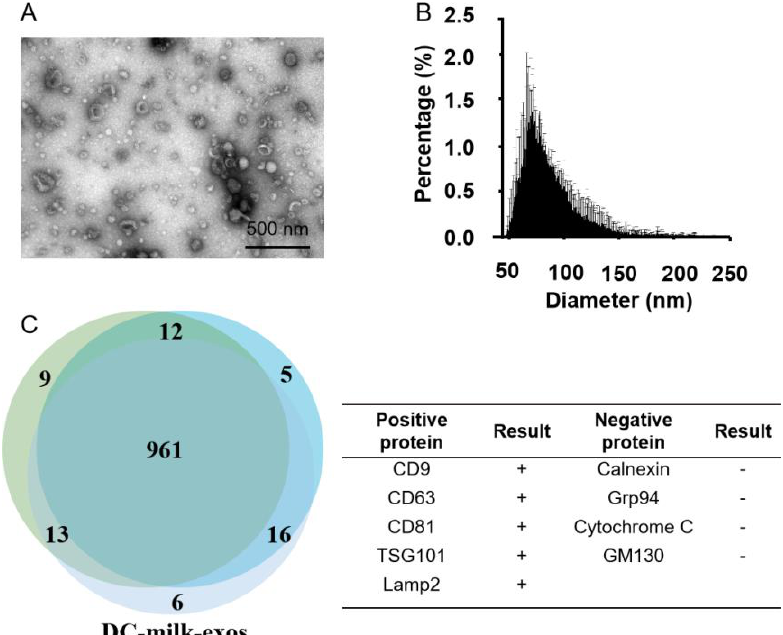
Figure 2. Characterization of DC-milk-exos. ( A ) The morphology and ( B ) the particle size analysis were detected via TEM and nanoFCM, respectively. ( C ) A three-way Venn diagram of proteins from three batches of DC-milk-exos revealed 1022 proteins common to all datasets. Cluster analyses for vital exosomal membrane markers CD9, CD63, CD81, and TSG101, microvesicle surface markers GM130, and endoplasmic reticulum (ER) marker calnexin are indicated in the table. Abbreviations: TEM, transmission electron microscope; DC-milk-exos, bovine-milk-derived exosomes via density gradient ultracentrifugation. Scale bars = 500 nm.